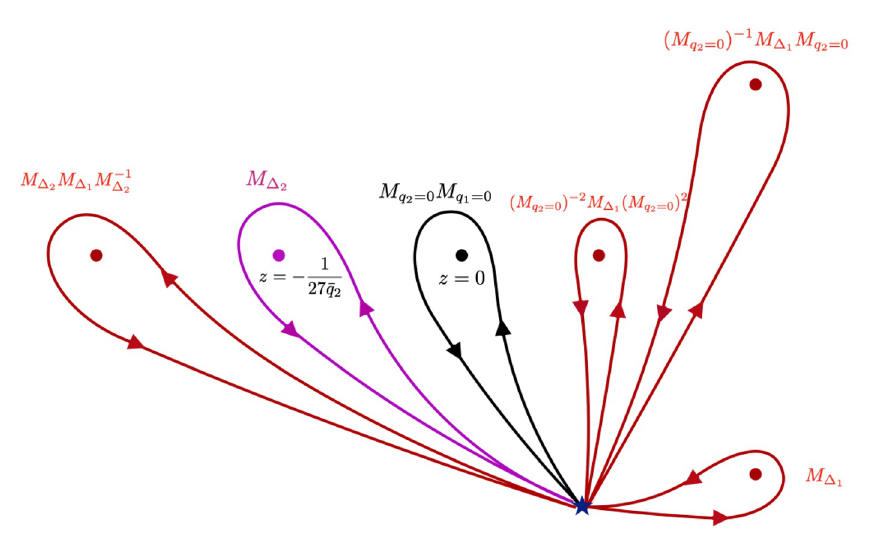
Figure 6. Positions of the regulator string for string solutions with e = (1 , 1) and 1 (cid:29) | ¯ q 1 | (cid:29) | ¯ q 2 | > 0 , together with the monodromies around them as measured along a loop encircling the strings